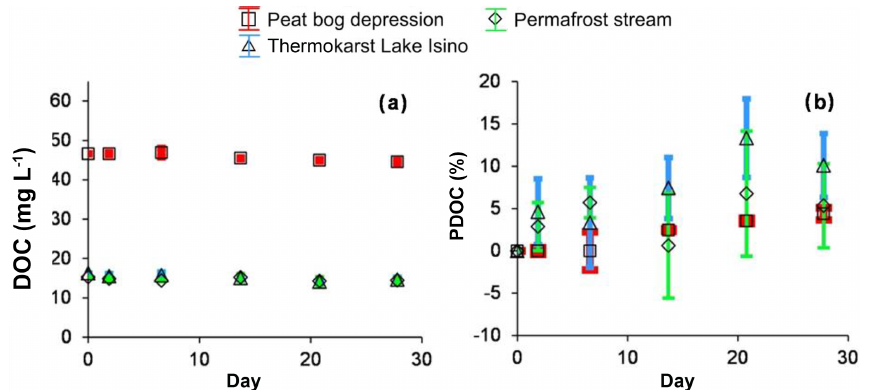
Figure 3. Concentration (a) and percentage (b) of degradable DOC in photodegradation experiments. The experiments are shown using solid symbols and the control runs are shown using open symbols: red squares represent the peat bog depression, green diamonds represent the permafrost stream and triangles represent the thermokarst Lake Isino. The error bars are ± 1SD of the triplicates.